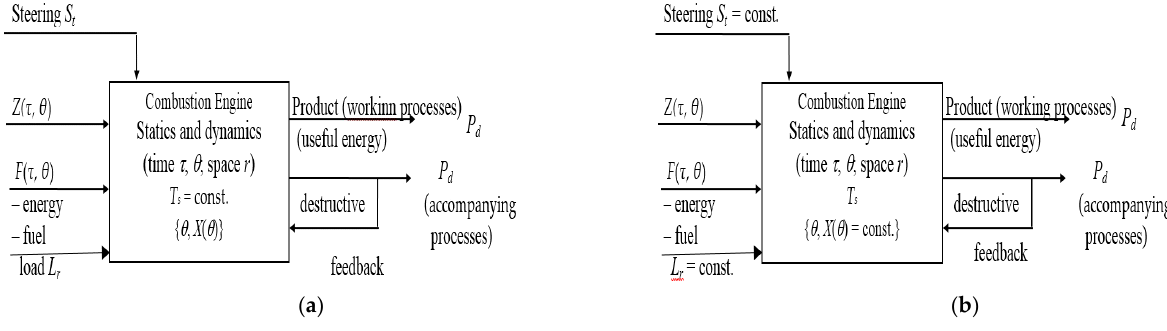
Figure 1. Diagnostic model in preliminary ( a ) and principal research ( b ).